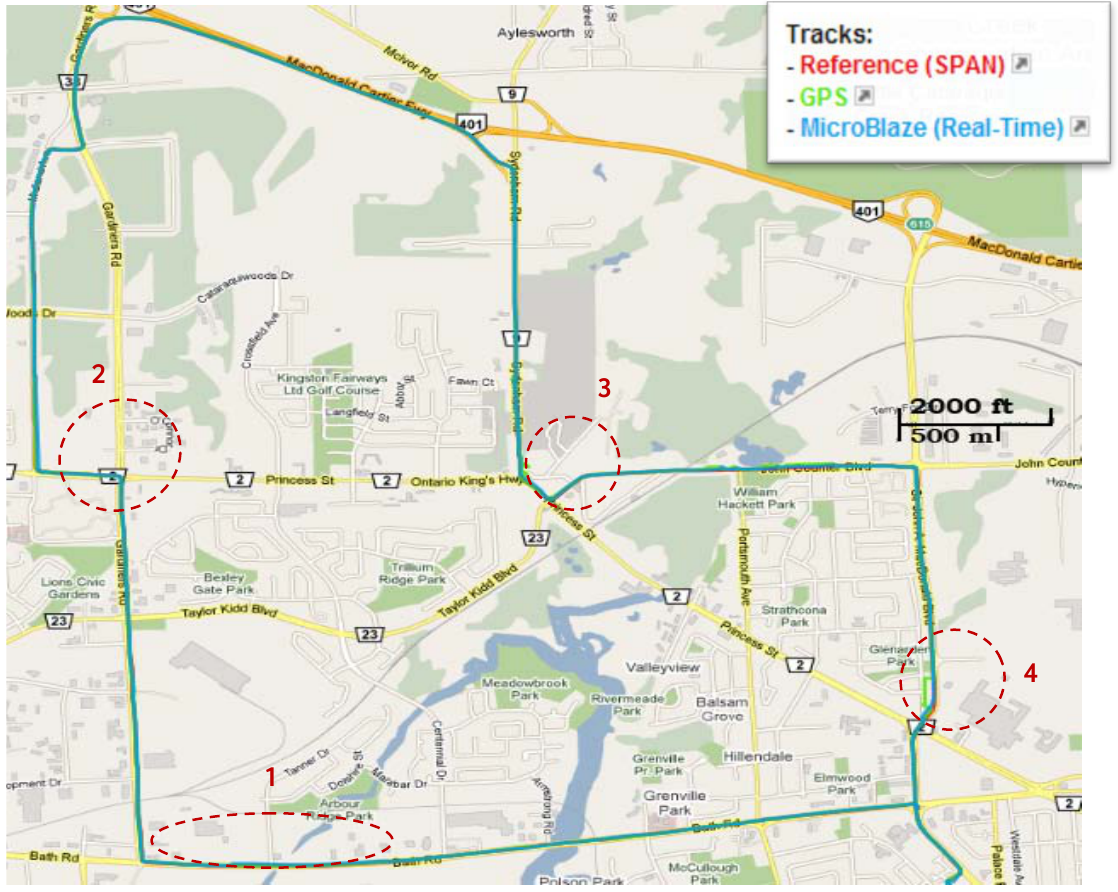
Figure 24. Land Vehicle Trajectory (2): Open Sky Area with Four Simulated GPS Outages.